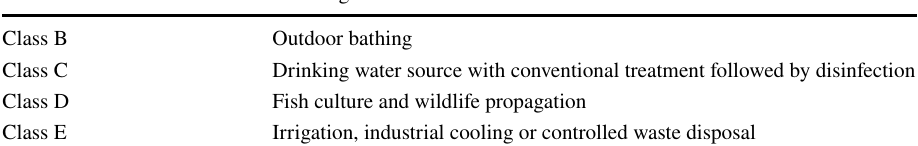
Table 8 Comparison of Water Quality Class as per BWQC and ISI-IS 2296–1982